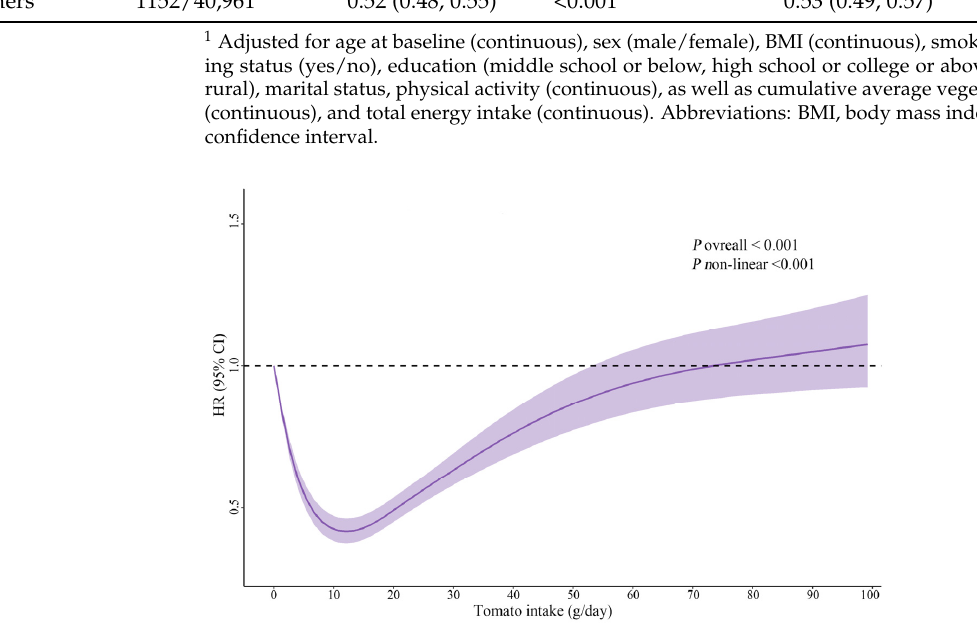
Figure 1. Dose-response relationship between dietary tomato intake and new-onset hypertension. Restricted cubic spline Cox proportional hazard regression model with 4 knots was adjusted for